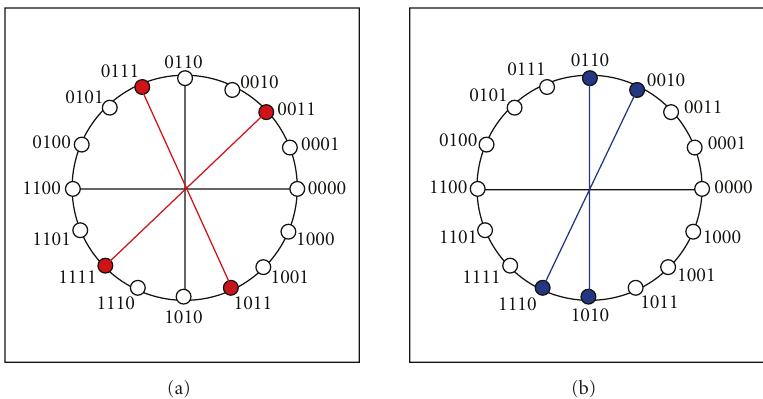
Figure 4: Two signal arrangement examples with Gray labeling 16-PSK where the nonshaping bits are fixed. In both cases, the shaping bits choose the most significant bits (MSB). (a) The nonshaping bits are 11. (b) The nonshaping bits are